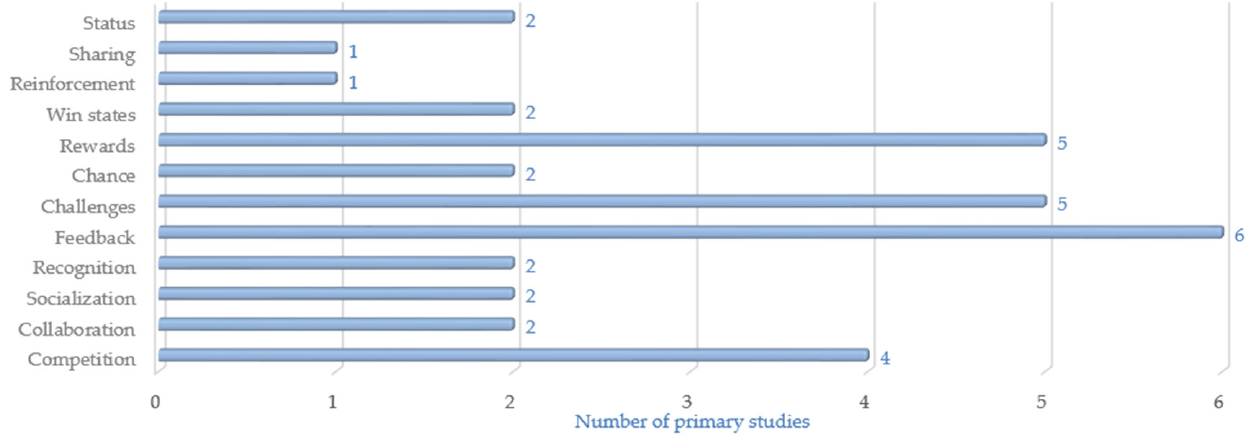
Figure 6. Number of primary studies by game mechanics.